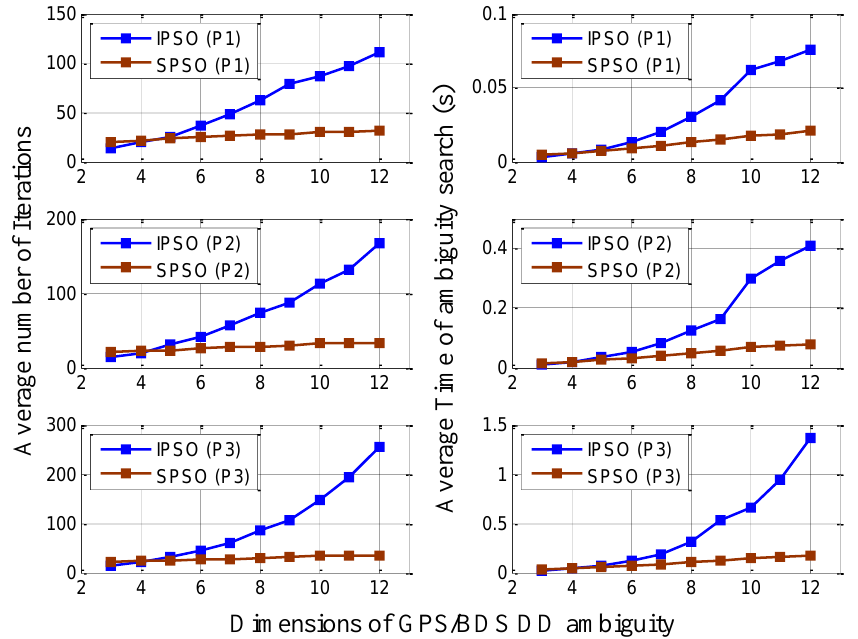
Figure 9. Average number of iterations and search time of IPSO/SPSO–AR under various DD ambiguity dimensions in Scheme #3.